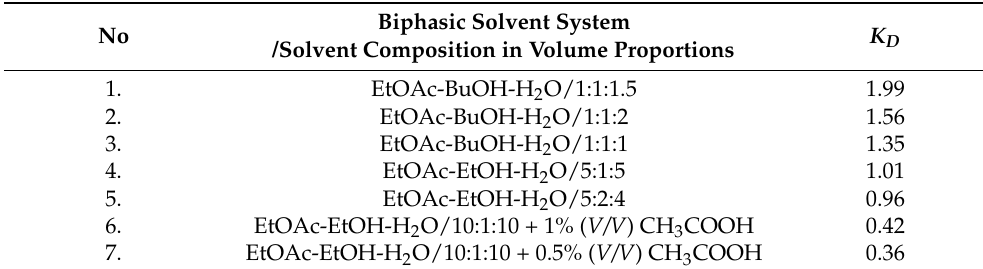
Table 1. Two-phase solvent systems used in the optimization of the CPC procedure with the re- lated partition coefficient ( K D ) values obtained for puerarin.